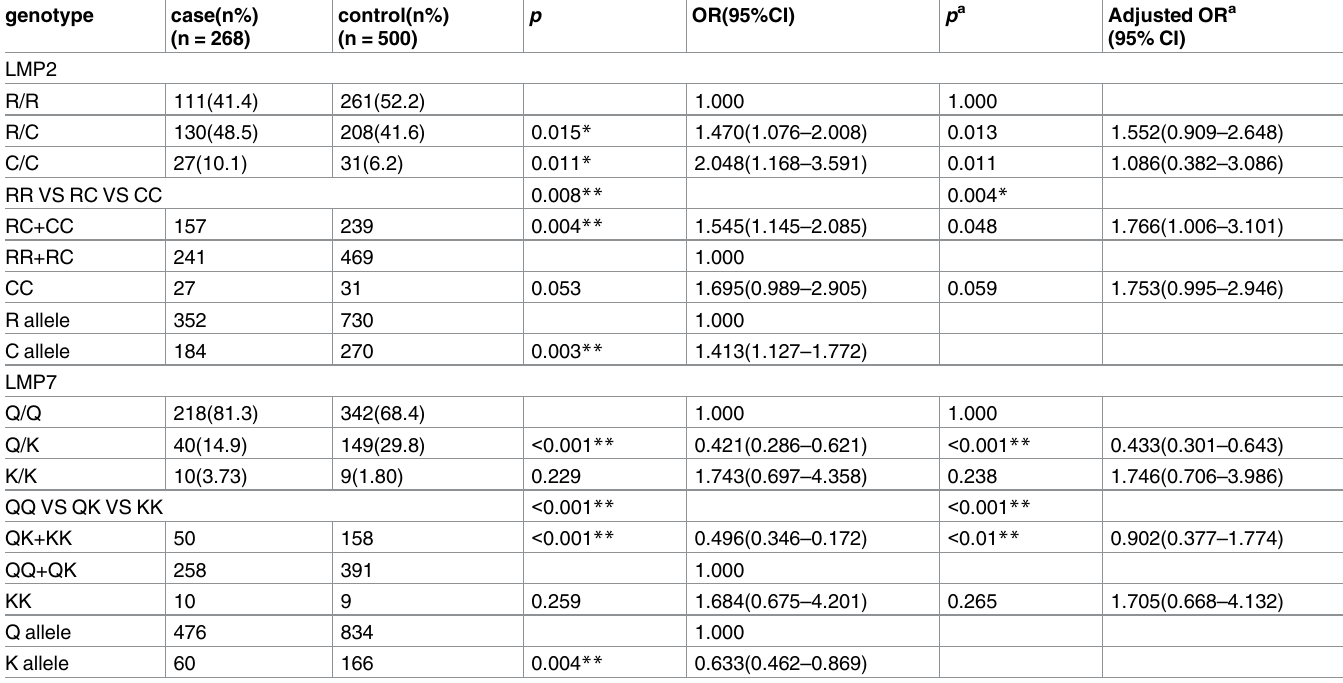
Table 2. Genotype frequencies of LMP2/LMP7 gene polymorphisms in cases and controls.